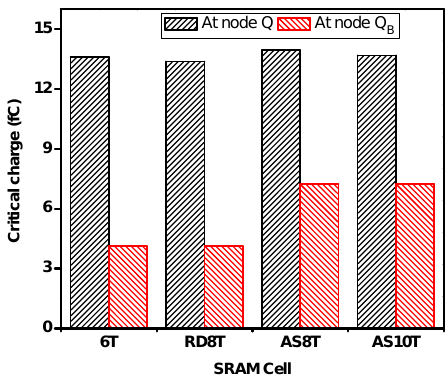
Figure 6. Critical charge at the storage nodes of SRAM cells considering logic ’0’ and ’1’ are stored at nodes Q and Q B ,